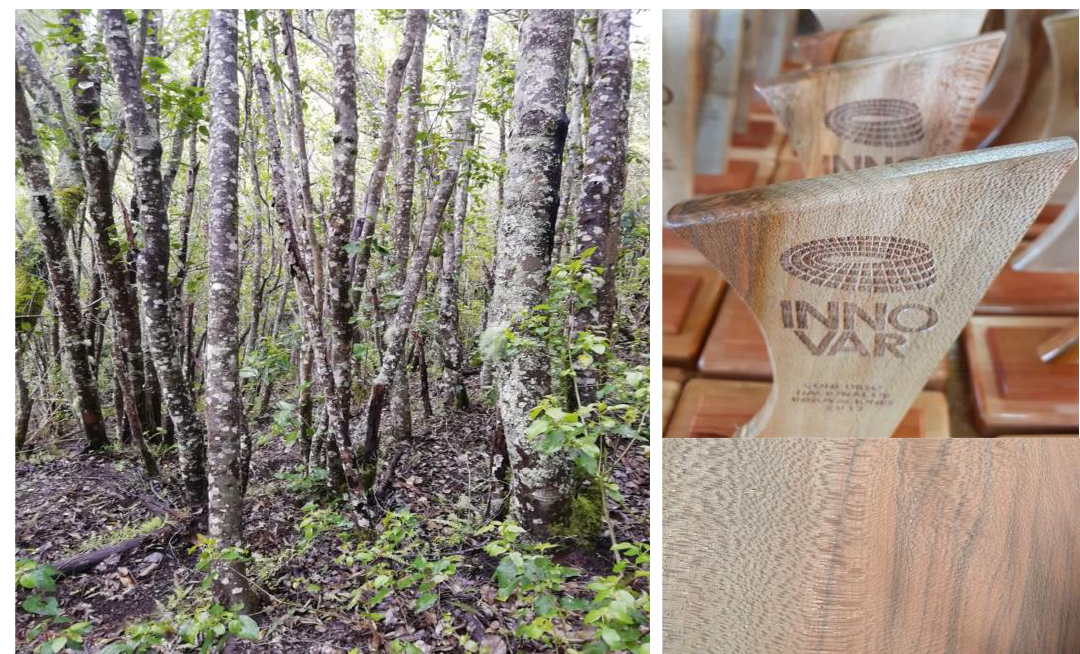
Figure 1. Lomatia hirsuta pure forest ( left ) and its wood ( right ).